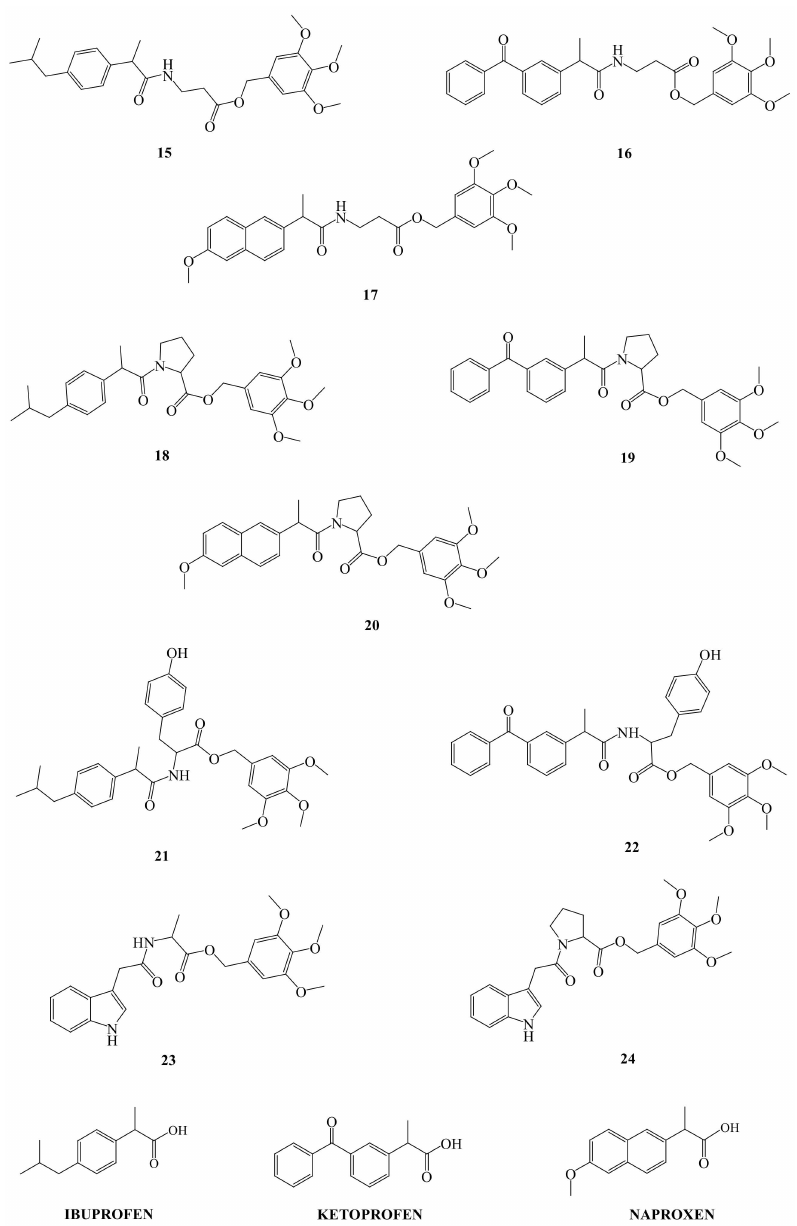
Figure 1. Structures of synthesized derivatives and of ibuprofen, ketoprofen, and